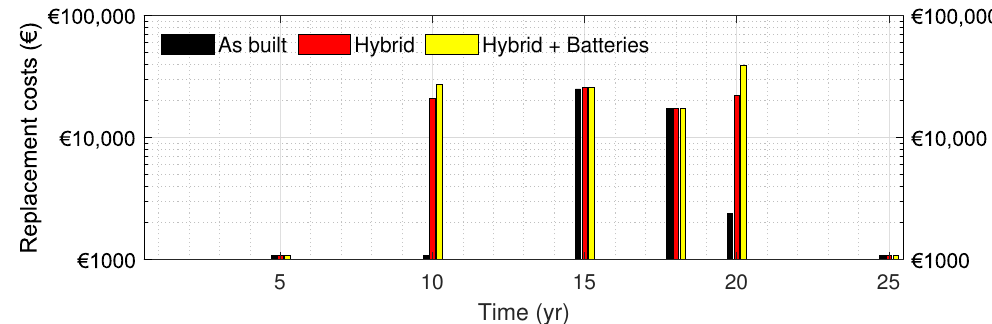
Figure 14. Replacement costs per scenario without integration, Scenario 1.